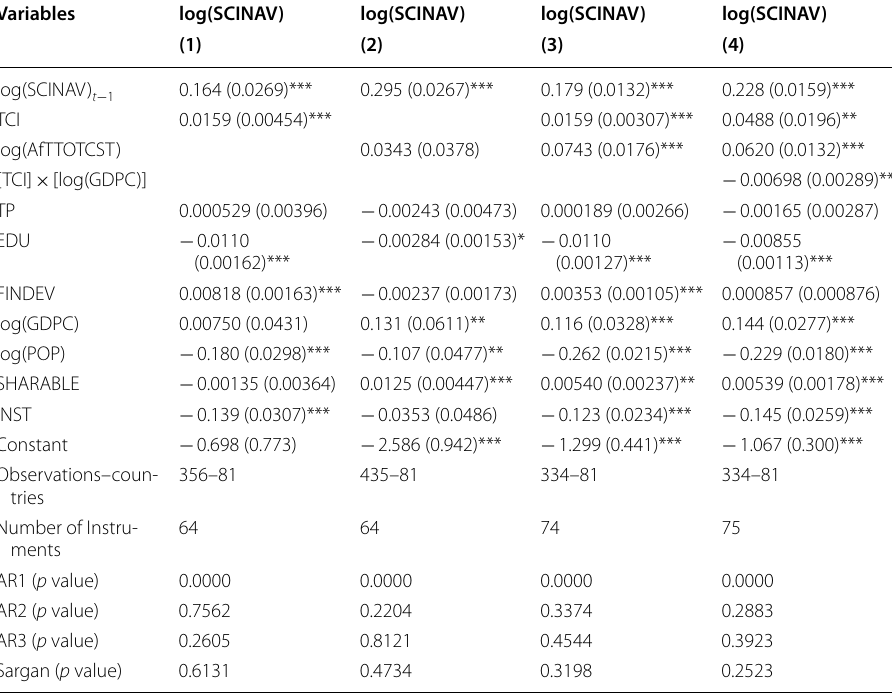
Table 2 Effect of AfT flows and development strategy on structural change in